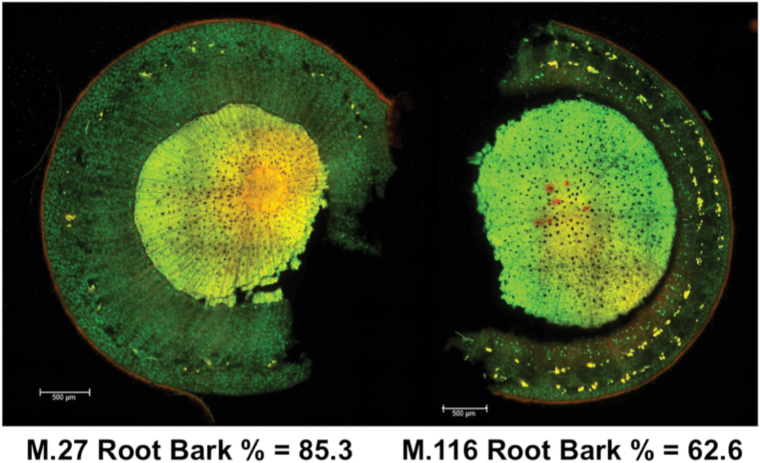
Root bark microscopy images depicting the root bark percentages for the two parents of the M432 mapping population, ‘M.27’ and ‘M.116’.